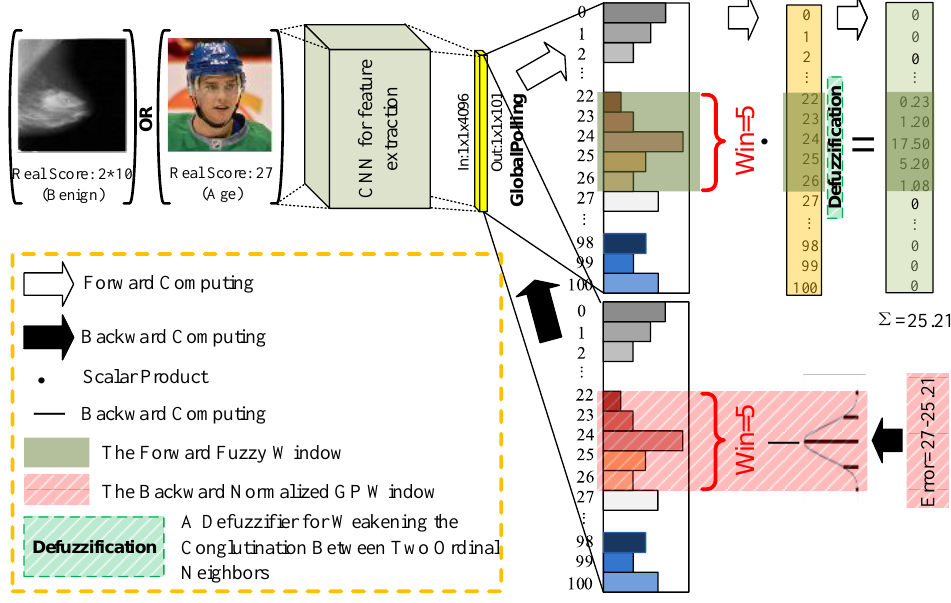
Figure 2. The proposed fuzzy window method (the length of the fuzzy window is 5) with the use of Gaussian processed labels for image scoring